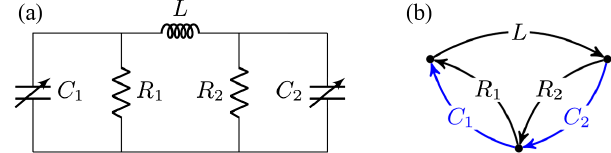
FIG. 3. (a) Two variable RC parallel circuits at possibly different temperatures coupled by an inductor. (b) Graph of the circuit. The only normal tree is shown in